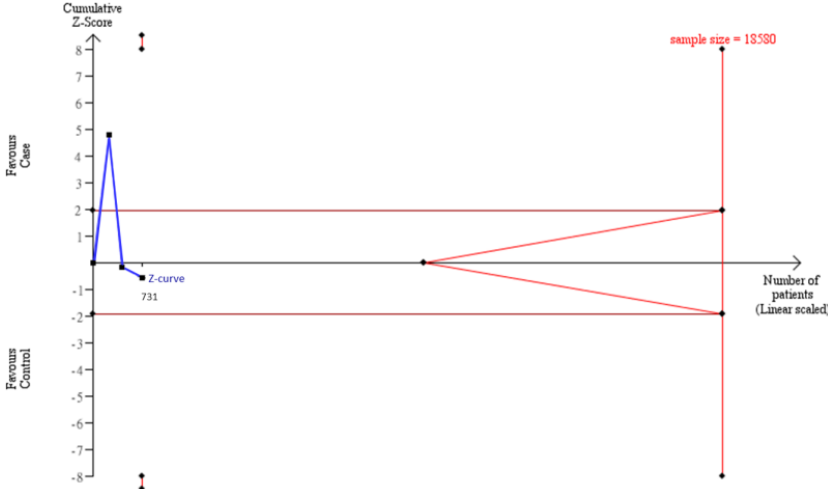
Figure 4. Trial Sequential Analysis (TSA) in Caucasians. We performed a TSA using an allele model assumption but replaced the allele count with the sample size (divided by 2). Detailed settings: Significance level = 0.05; Power = 0.8; ratio of controls to cases = 1; hypothetical proportion of controls with 2G allele = 0.47; least extreme OR to be detected = 1.3; I 2 (heterogeneity) = 80%.